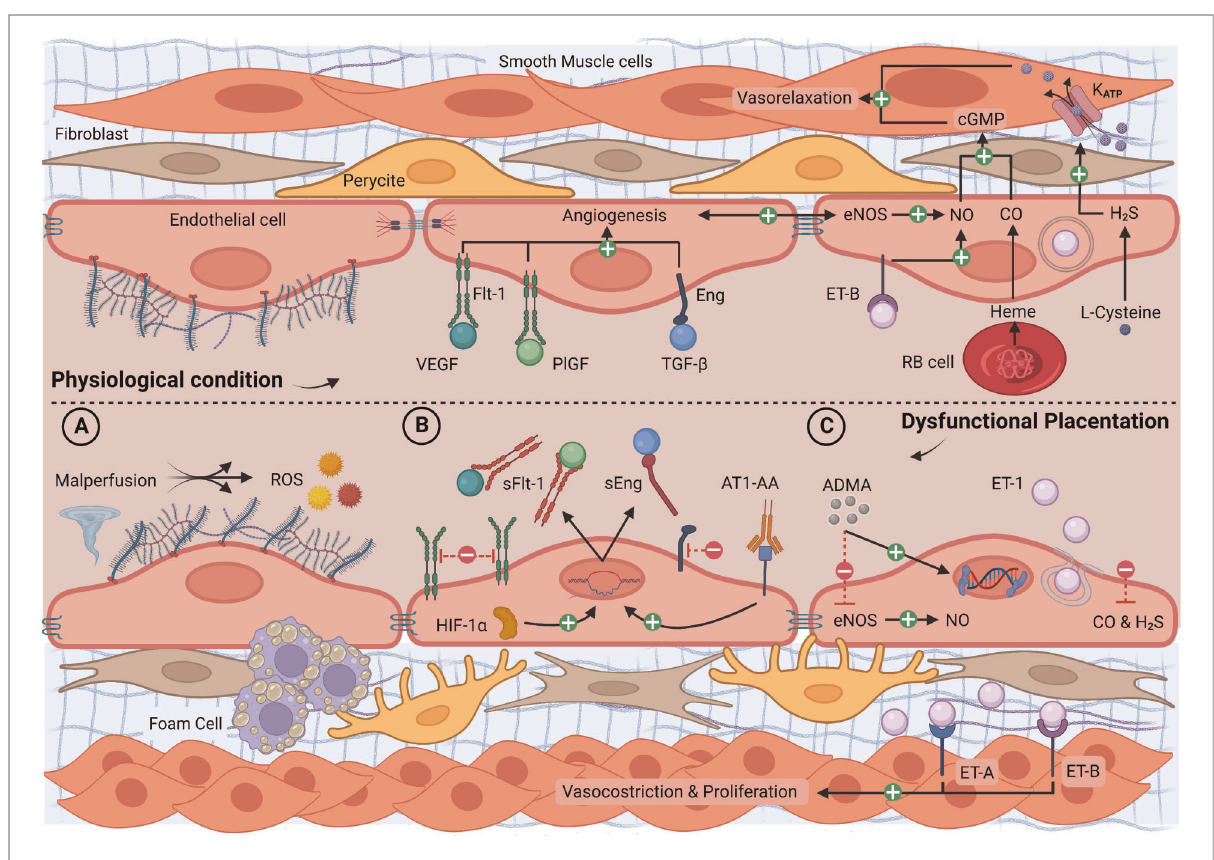
FIGURE 2 Longitudinal section of a blood vessel: endothelial phenotype in physiological conditions and dysfunctional placentation endotype. ( A ) Malperfusion phenomena with shear stress, hypoxia, reperfusion injury, atherosclerosis, and ROS production; ( B ) high levels of HIF-1 α and AT1-AA with increased synthesis of sFlt-1 and sEng, reduced free circulating VEGF, PlGF, TGF- β , and reduced angiogenesis; ( C ) high levels of ADMA and ET-1 and low levels of gasotransmitters with increased vasoconstriction, smooth muscle layer proliferation, and epigenetic mutations. ADMA, asymmetric dimethylarginine; AT1-AA, angiotensin II type 1 agonistic receptor autoantibody; cGMP, cyclic guanosine monophosphate; CO, carbon monoxide; eNOS, endothelial nitric oxide synthase; ET-1, endothelin-1; ET-A/B, endothelin-1 receptor A/B; H 2 S, hydrogen sul fi de; HIF-1 α , hypoxia-inducible factor 1 α ; Katp, potassium channel; PlGF, placental growth factor; RB cell, red blood cell; ROS, reactive oxygen species; sEng, soluble endoglin; sFlt-1, soluble fms-like tyrosine kinase-1; TGF- β , transforming growth factor- β ; NO, nitric oxide; VEGF, vascular endothelial growth factor. Created with